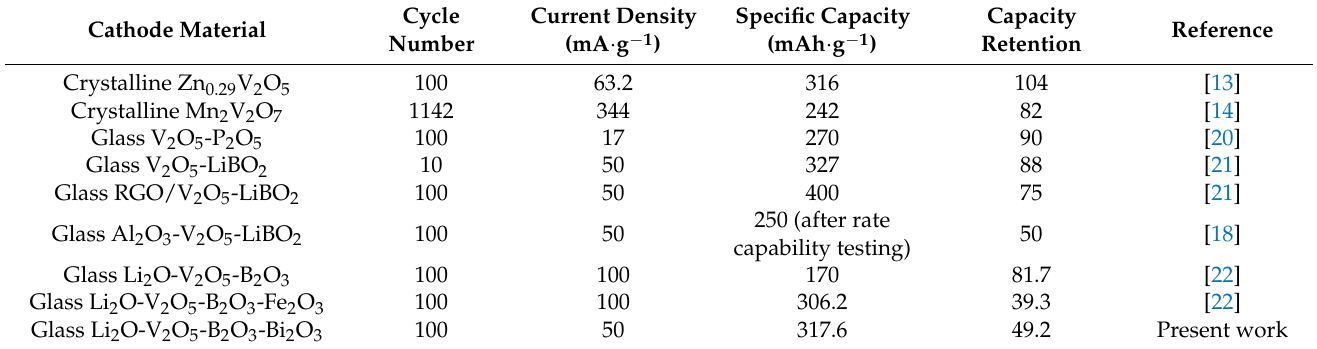
Table 1. Different vanadate cathode materials and their cycling properties reported in the